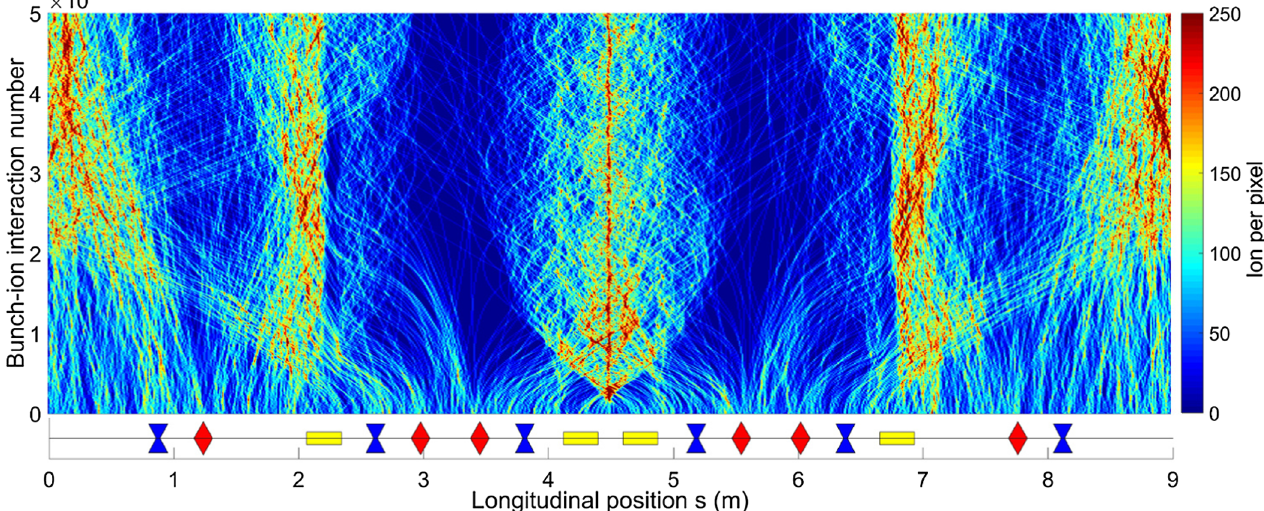
FIG. 4. Tracking of a CO þ ion cloud during 50 000 bunch-ion interactions, starting from an uniform distribution in the longitudinal dimension. The ion density is plotted vs the time (expressed in bunch-ion interactions) in ordinate and vs the longitudinal position for half of the ThomX storage ring in abscissa. The number of ions at the start of the simulation is N i 0 ¼ 10 5 . The bottom plot is a synopsis of the ThomX storage ring elements taken into account for the simulation. Focusing quadrupoles are represented in blue, defocusing quadrupoles are represented in red and dipoles in